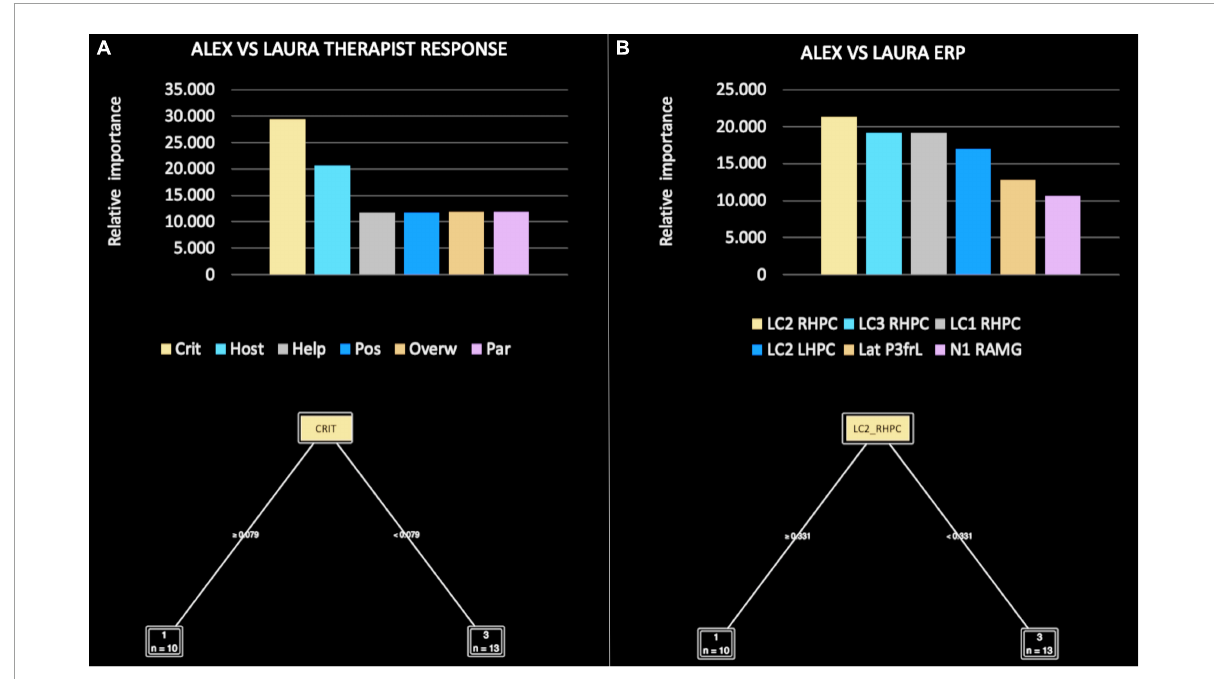
FIGURE6 Relative importance of all therapist response patterns (A) and event-related potential (ERP) components (B) , included in the machine learning (ML) model for Alex versus Laura.